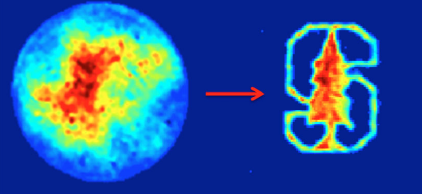
FIG. 2. Original beam profile (left) and Stanford tree profile at VCC (right).